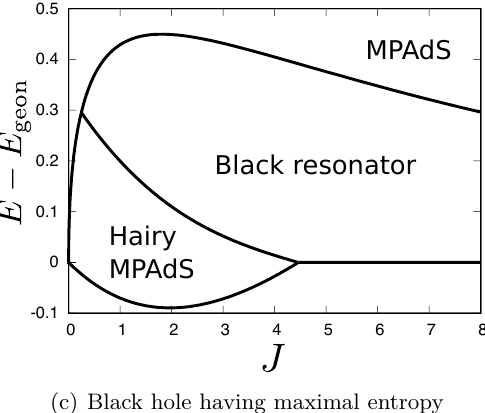
Figure 7 . (a) Entropy of the hairy MPAdS for j = 9 / 2 (orange) and j = 5 (green). (b) Phase diagram of asymptotically AdS solutions in Einstein-multiple complex scalar fields system for j = 5 . (c) Black hole having maximal entropy among the MPAdS, hairy MPAdS, black resonator, and hairy black resonator for j = 5